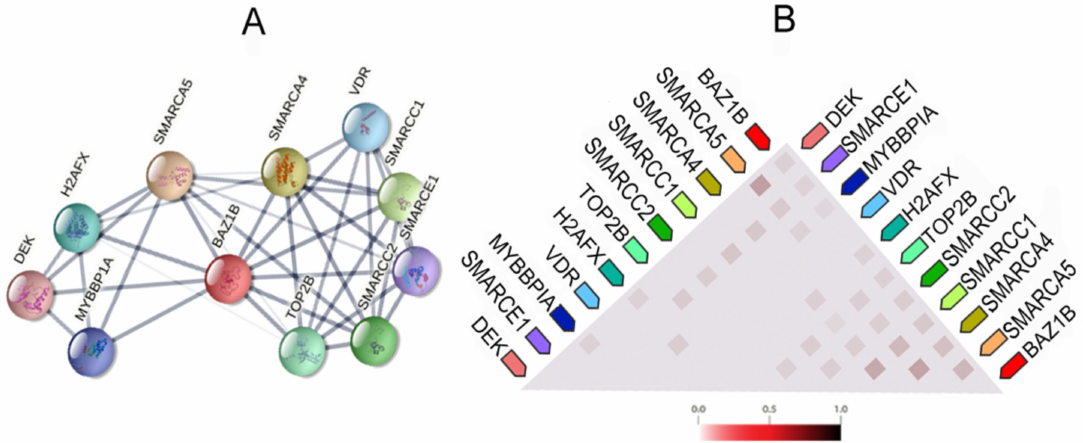
Figure 3. BAZ1B co-expression and interactions. Figures are obtained from STRING database [10]. ( A ) Each node in the network represents all proteins produced by a single, protein-coding gene locus, i.e., splice isoforms or posttranslational modifications are collapsed. Edges represent protein–protein association, which are meant to be specific and meaningful. Proteins jointly contribute to a shared function; however, this does not necessarily mean they are physically binding each other. Line thickness indicates the strength of data support. ( B ) Co-expression of BAZ1B and first shell of interactors. The color intensity in the triangular matrices indicates the level of confidence that two proteins are functionally associated, given the overall expression data in the